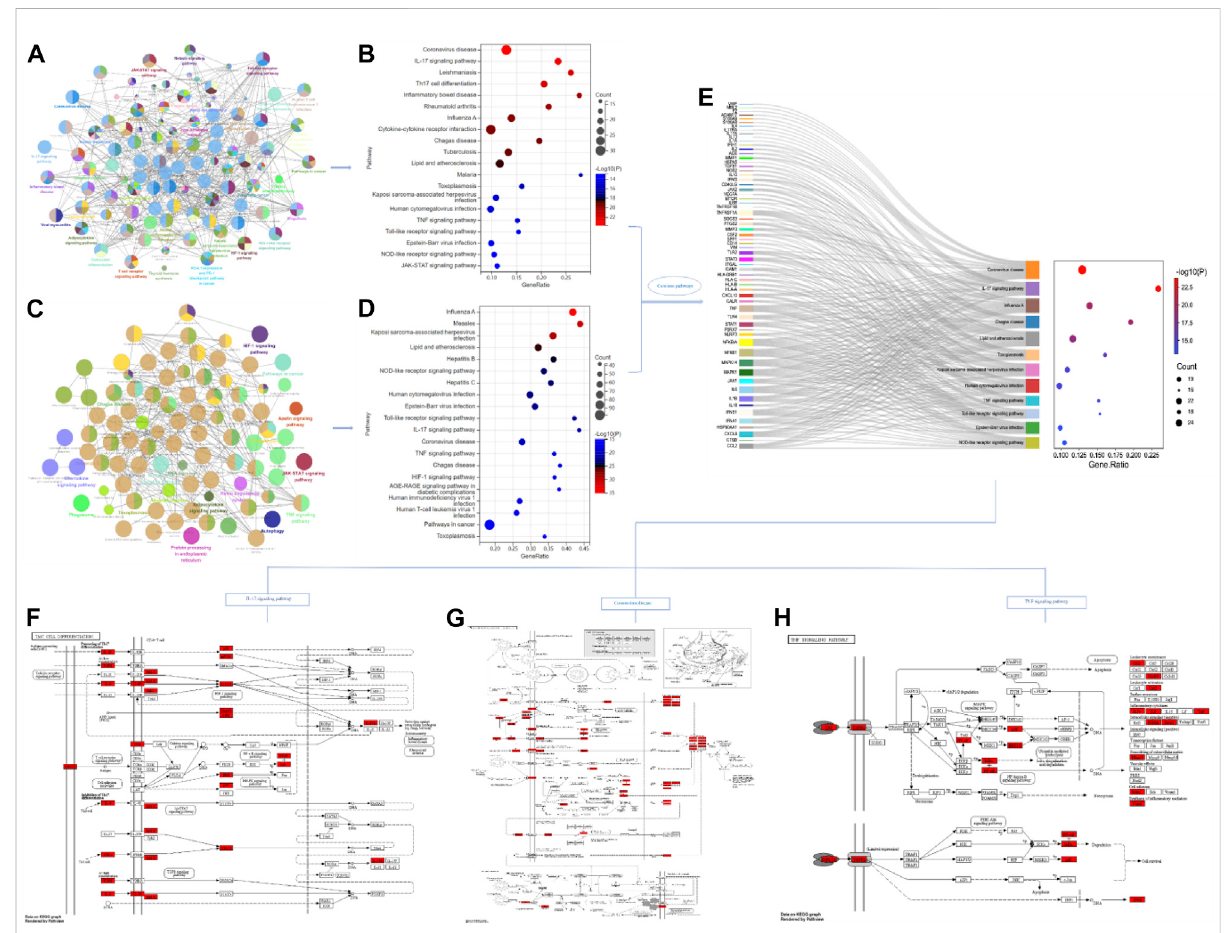
FIGURE 4 Common signaling pathways of single disease (COVID-19) and multiple disease combinations (COVID-19, RA, AS, GA). (A,B) The common signaling pathways involved in multiple disease combinations (COVID-19, RA, AS, GA) and the pathways that rank TOP20 among them. (C,D) The signaling pathways regulated by single disease (COVID-19) and the pathways of ranking TOP20. (E) Based on the intersection analysis of TOP20 pathways in single disease (COVID-19) and multiple disease combinations (COVID-19, RA, AS, GA), 12 common regulated signaling pathways were obtained, including Coronavirus disease, TNF signaling pathway, IL-17 signaling pathway, and showed the enriched targets on each pathway. (F – H) Speci fi c signaling transduction pathways of Coronavirus disease, TNF signaling pathway and IL-17 signaling